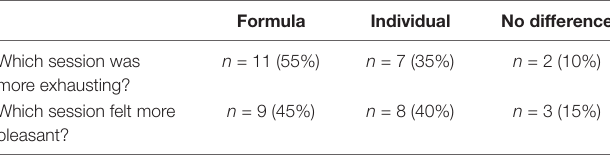
TABLE 5 | Survey of different perceived feelings between formula and individual session. Formula Individual No